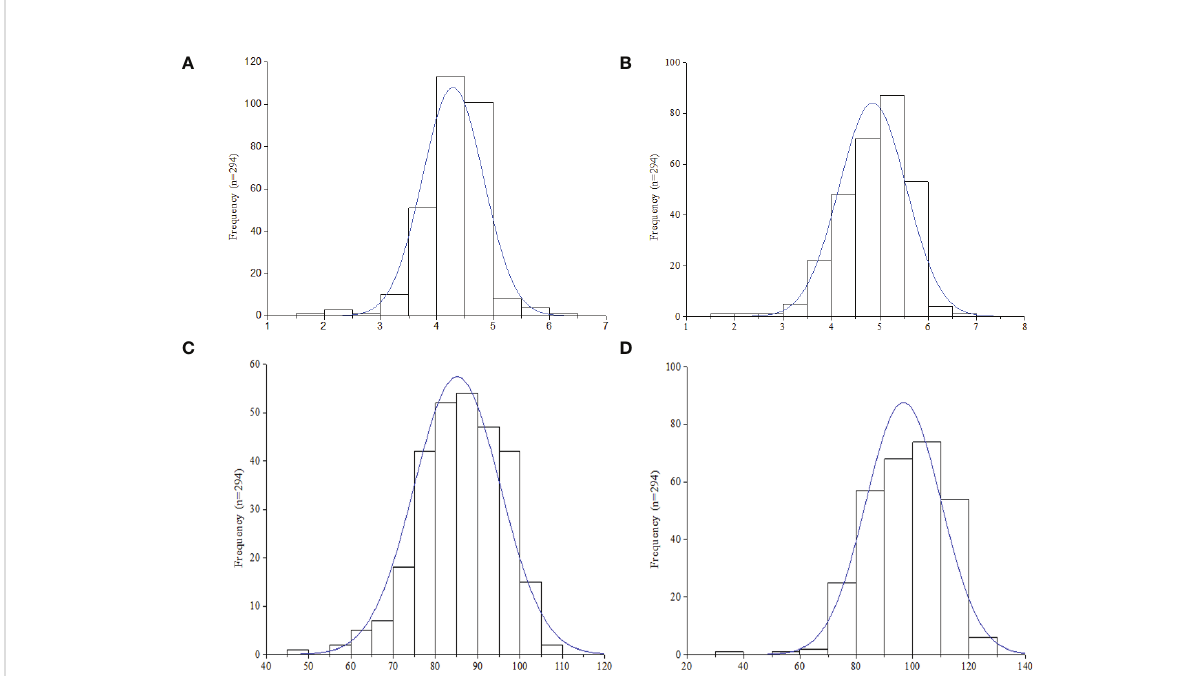
FIGURE 1 Frequency distribution of leaf spot diseases rating in the 294 accessions (n) in this study. (A) Early leaf spot (ELS). (B) Late leaf spot (LLS). (C) Area under disease progression curve (AUDPC) -ELS. (D) AUDPC -